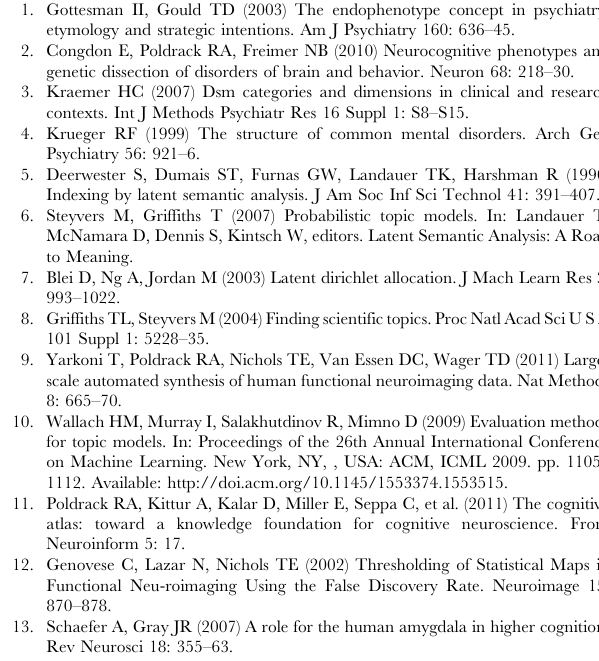
Table S2 Complete list of topics identified through application of latent Dirichlet allocation to the text corpus filtered for mental disorder terms. The top 5 words shown for each topic are those which had the highest loading for that topic across